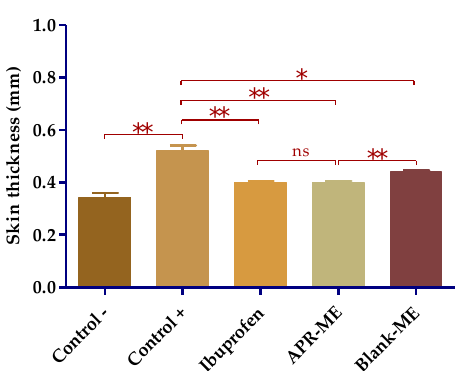
Figure 9. Ear thickness. Results are expressed as mean ± SD ( n = 3). Statistically significant differences: *, p < 0.05; **, p < 0.01; ns, not significant.